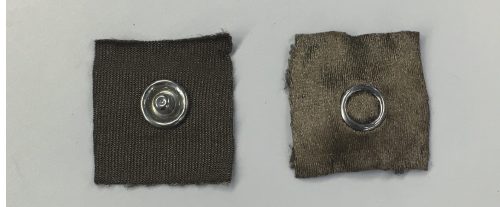
Figure 4. Conductive fabric electrodes where electrode surface contacts skin ( right ) and electrode surface contacts socks ( left ). Electric signals are measured through snaps located at center of electrodes.